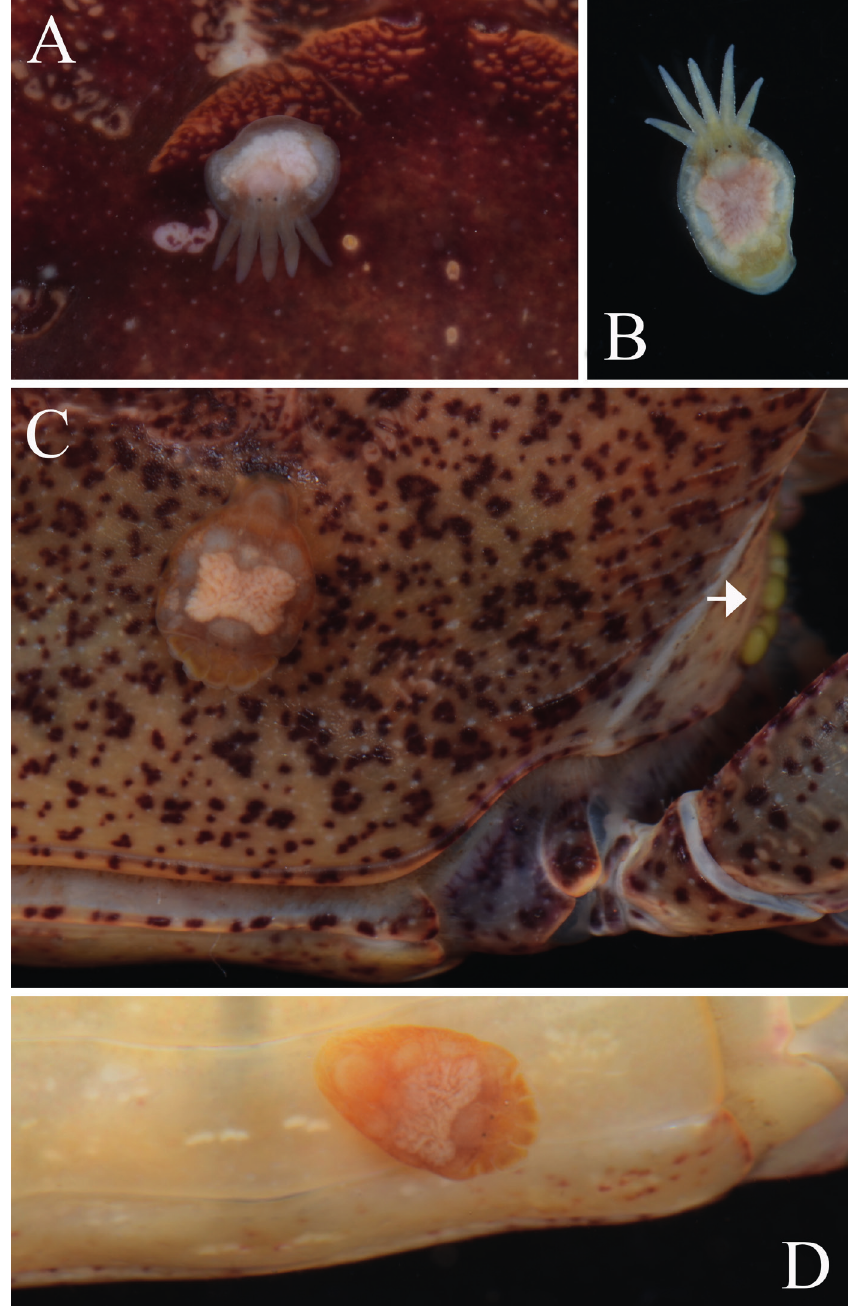
Figure 6. Symbiotic flatworm (Temnocephalida, possibly species of Temnosewellia Damborenea and Cannon, 2001) associated with Sundathelphusa tuerkayi , new species, in Lombok, Indonesia. A, flatworm in situ on carapace, with tentacles extended; B, flatworm in vitro ; C, flatworm in situ on carapace, with tentacles retracted, arrow pointing to eggs attached to right branchiostegium (see also Fig. 1A); D, flatworm in situ on abdomen, with tentacles